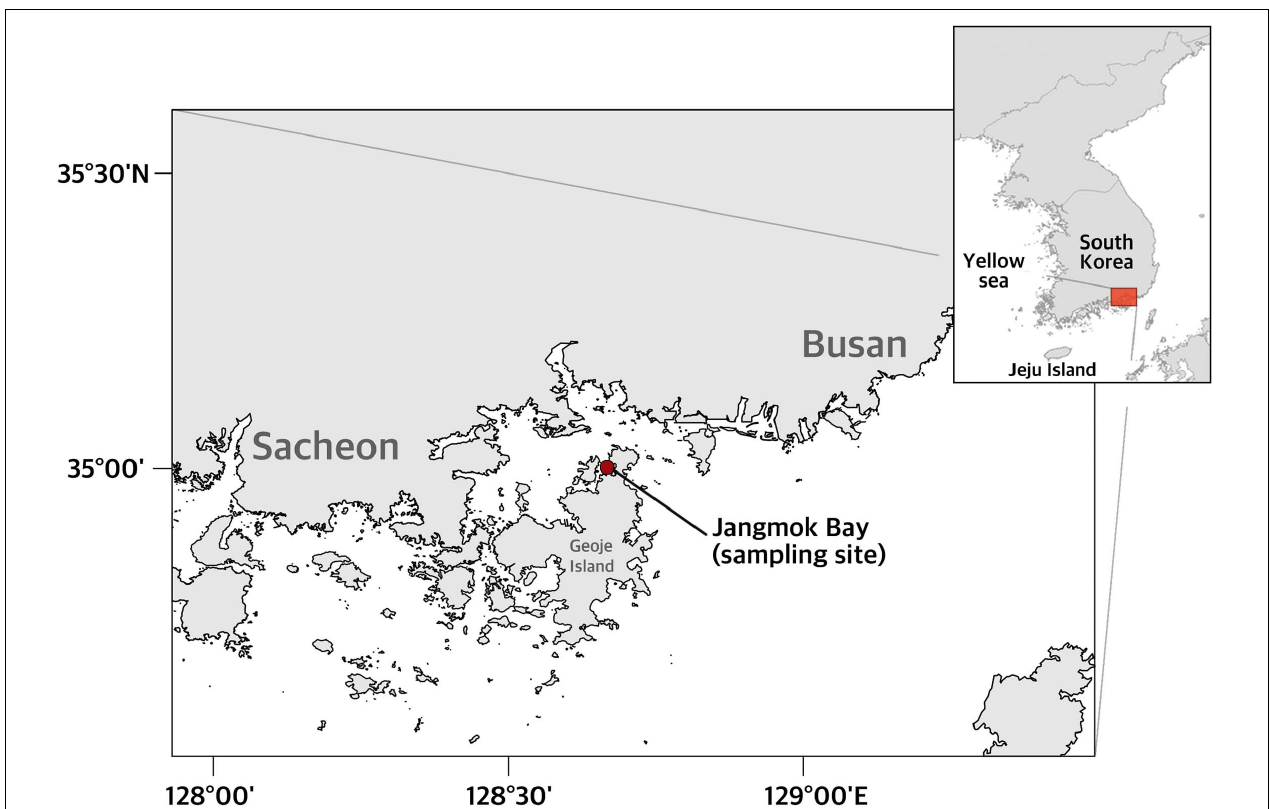
FIGURE 1 | Location of sampling site, Jangmok Bay, on the southeastern coast of